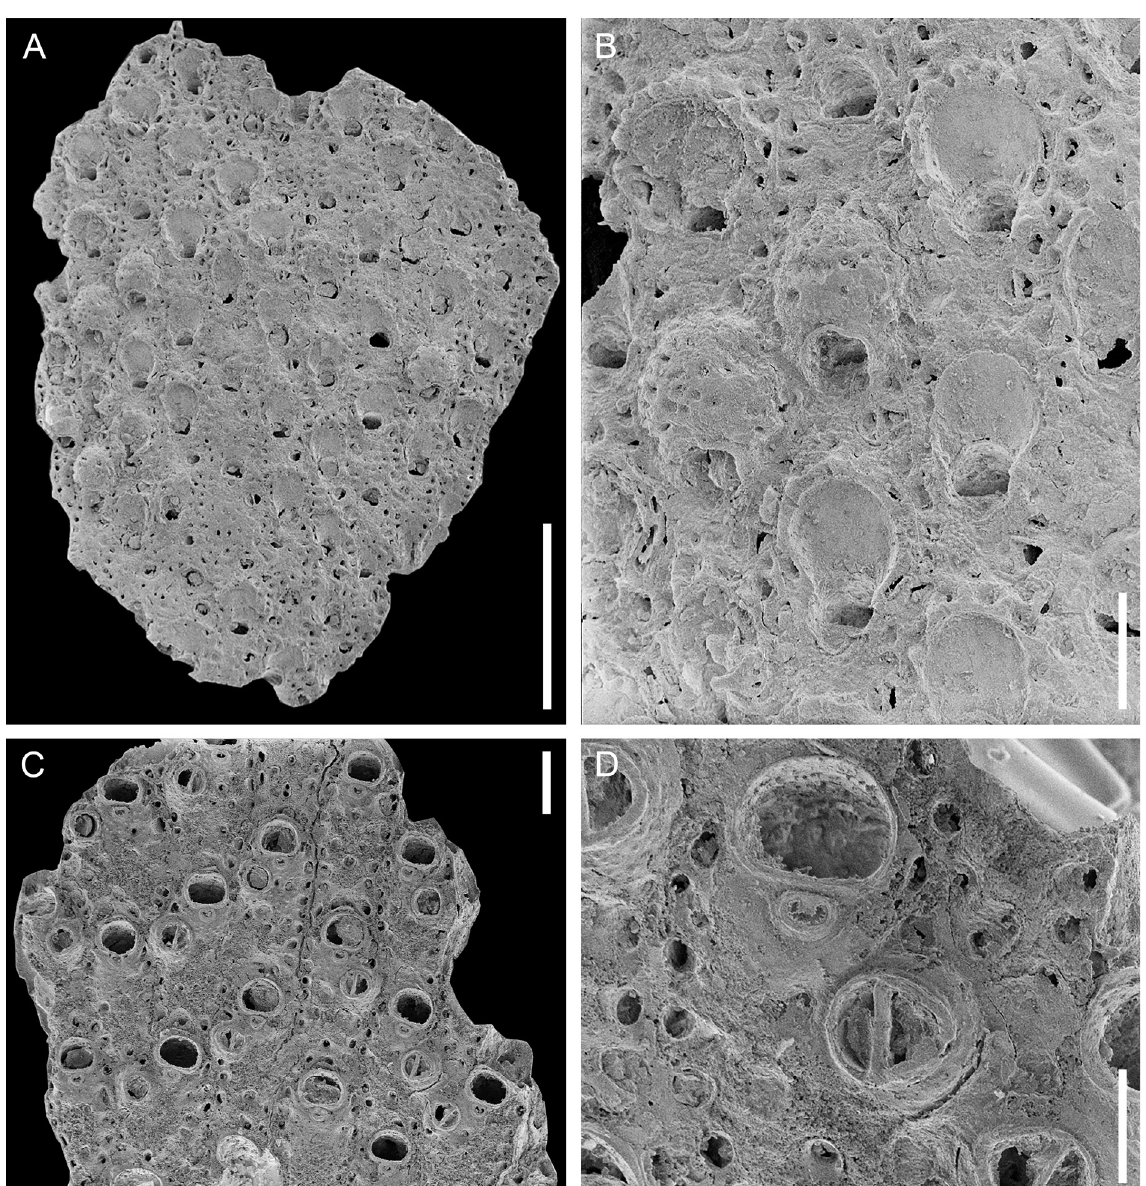
Fig. 1. Microporella bifoliata Ulrich & Bassler, 1904, Miocene, Choptank Formation, Maryland, USA. A–B . Lectotype USNM 68592A. A . General view of the branch fragment. B . Group of zooids, mostly ovicellate. C–D . Paralectotype USNM 68592B. C . Group of autozooids. D . Close-up of an autozooid. Scale bars: A = 1 mm; B–C = 200 µm; D = 100